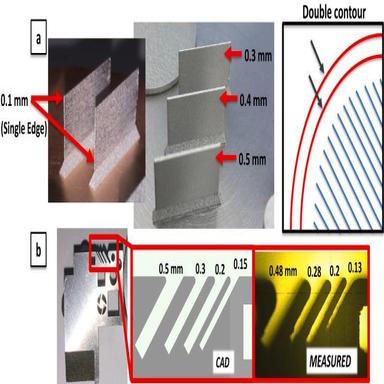
(a) Thin walls with different thickness (0.5–0.4 - 0.3–0.1 mm) produced with double contour scanning strategy; (b) beams offset tuning for complex geometry production and measurement of gap left between parts.